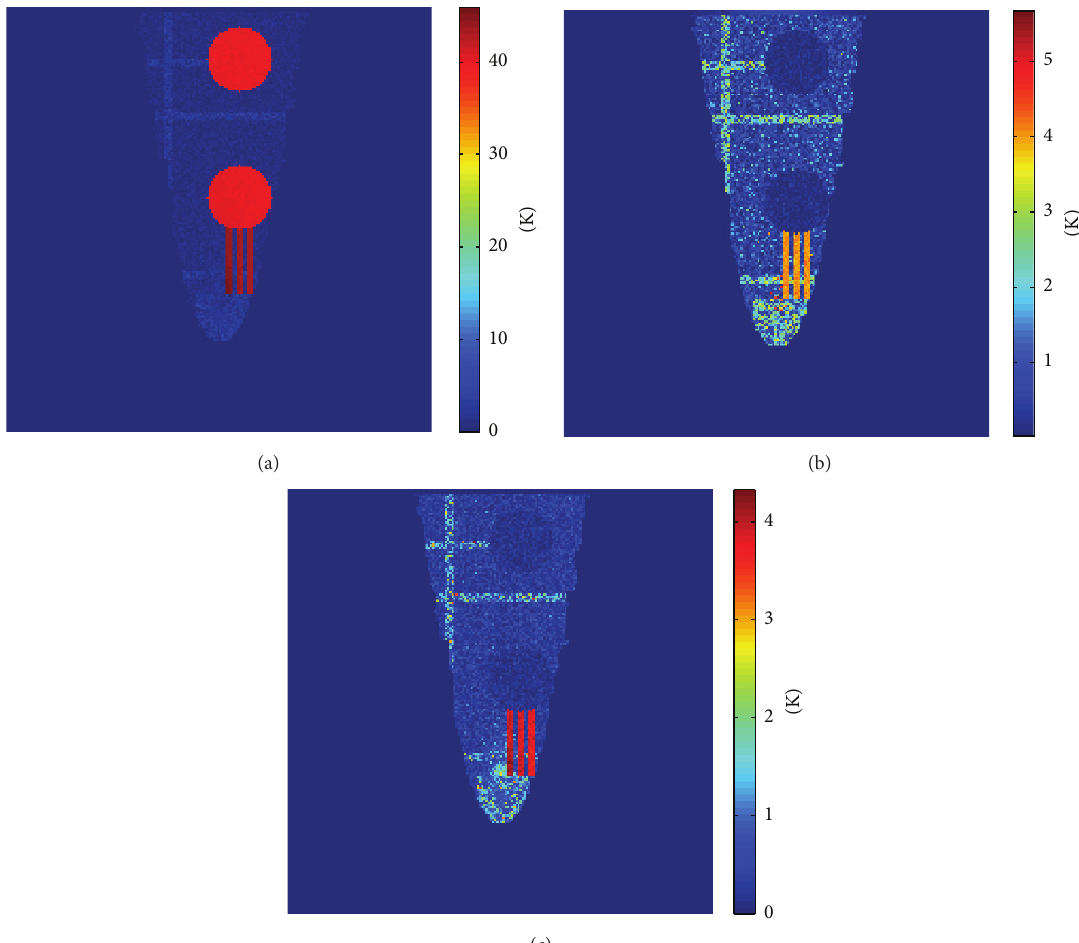
Figure 11: Mean error of background radiance estimation, expressed in terms of brightness temperature. (a) Mean error obtained with the Selected-Band estimation method. (b) Mean error obtained with the Clustering-Based estimation method. (c) Mean error obtained with the Clustering-Based Selected-Band estimation